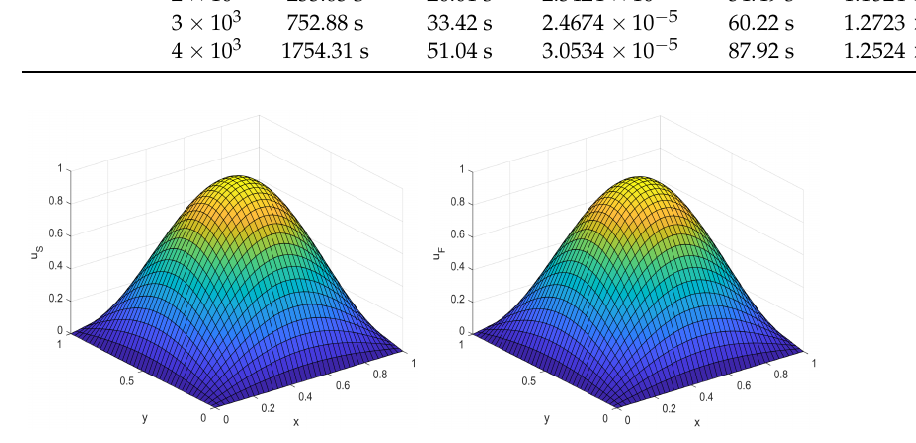
Figure 3. Numerical solution for Case 4 at the final time t = 1 with α = 0.2, N = 4000, K = 30. ( a ) Numerical solution by standard method. ( b ) Numerical solution by fast algorithm.